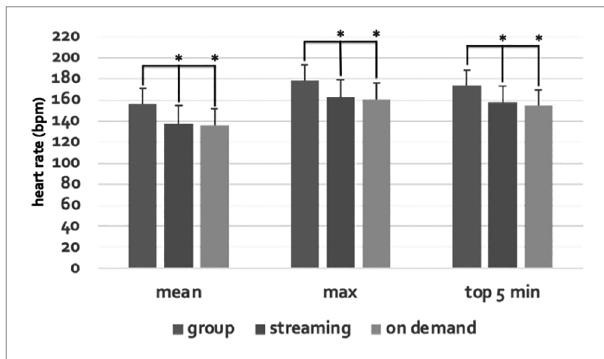
FIGURE 2 Mean class heart rate, max heart rate, and mean heart rate for the fi ve minutes at the highest intensity during the live group format compared to both live streaming and on demand An * equals a statistical difference with live group (all values p <0.001). In addition, there was no difference in any heart rate variables between the streaming and on demand